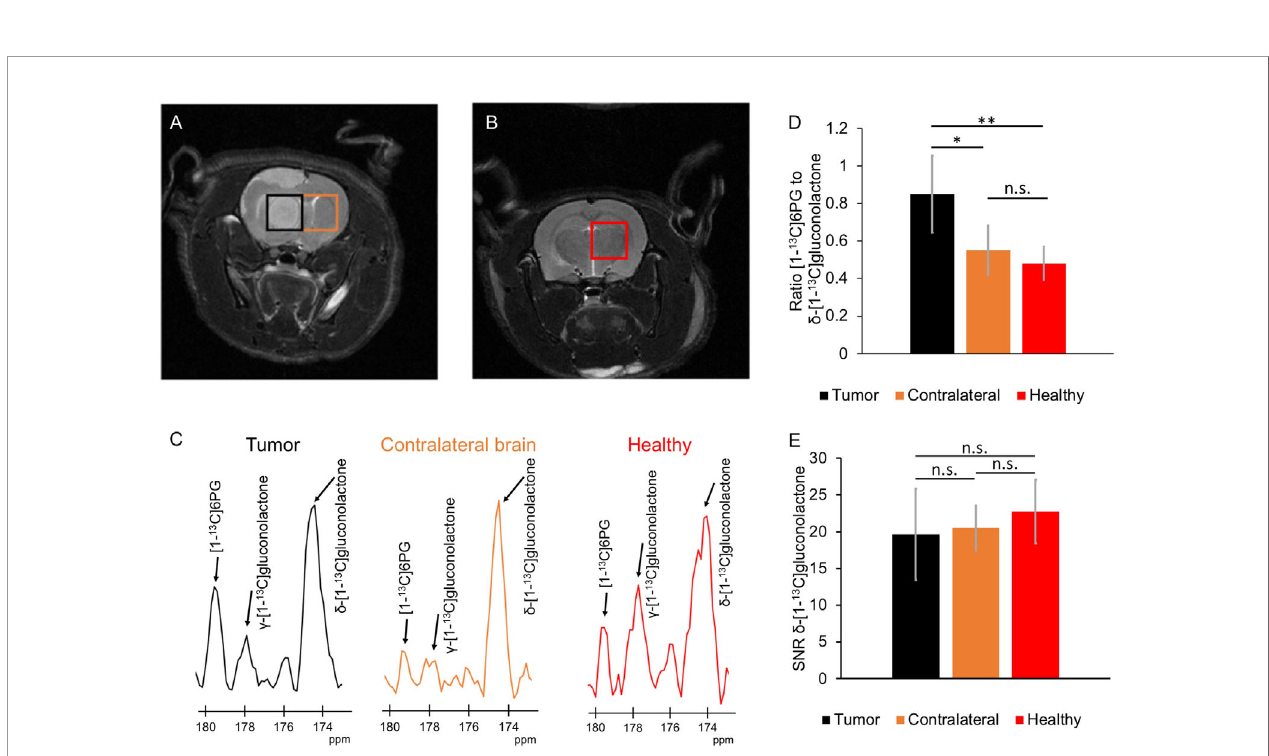
FIGURE 7 | Hyperpolarized d -[1- 13 C]gluconolactone metabolism to [1- 13 C]6PG can differentiate tumor from normal brain in vivo . (A) Representative T2-weighted MRI from 2D EPSI studies of hyperpolarized d -[1- 13 C]gluconolactone metabolism showing placement of the tumor voxel (black) and normal-appearing contralateral brain voxel (orange) in a rat bearing an orthotopic U87 tumor xenograft. (B) Representative T2-weighted MRI from 2D EPSI studies in a tumor-free healthy rat. The voxel from healthy brain is shown in red. (C) Representative 13 C MR spectra from tumor (black) and normal-appearing contralateral brain (orange) voxels from a U87 tumor-bearing rat and healthy brain voxel (red) from a tumor-free control rat. Quanti fi cation of the ratio of [1- 13 C]6PG to d -[1- 13 C]gluconolactone (D) and the SNR of d -[1- 13 C]gluconolactone (E) in ROIs from tumor (black), normal-appearing contralateral brain (orange) and healthy tumor-free brain (red). n = 6; * indicates p<0.05, ** indicates p<0.01: ns indicates non signi fi